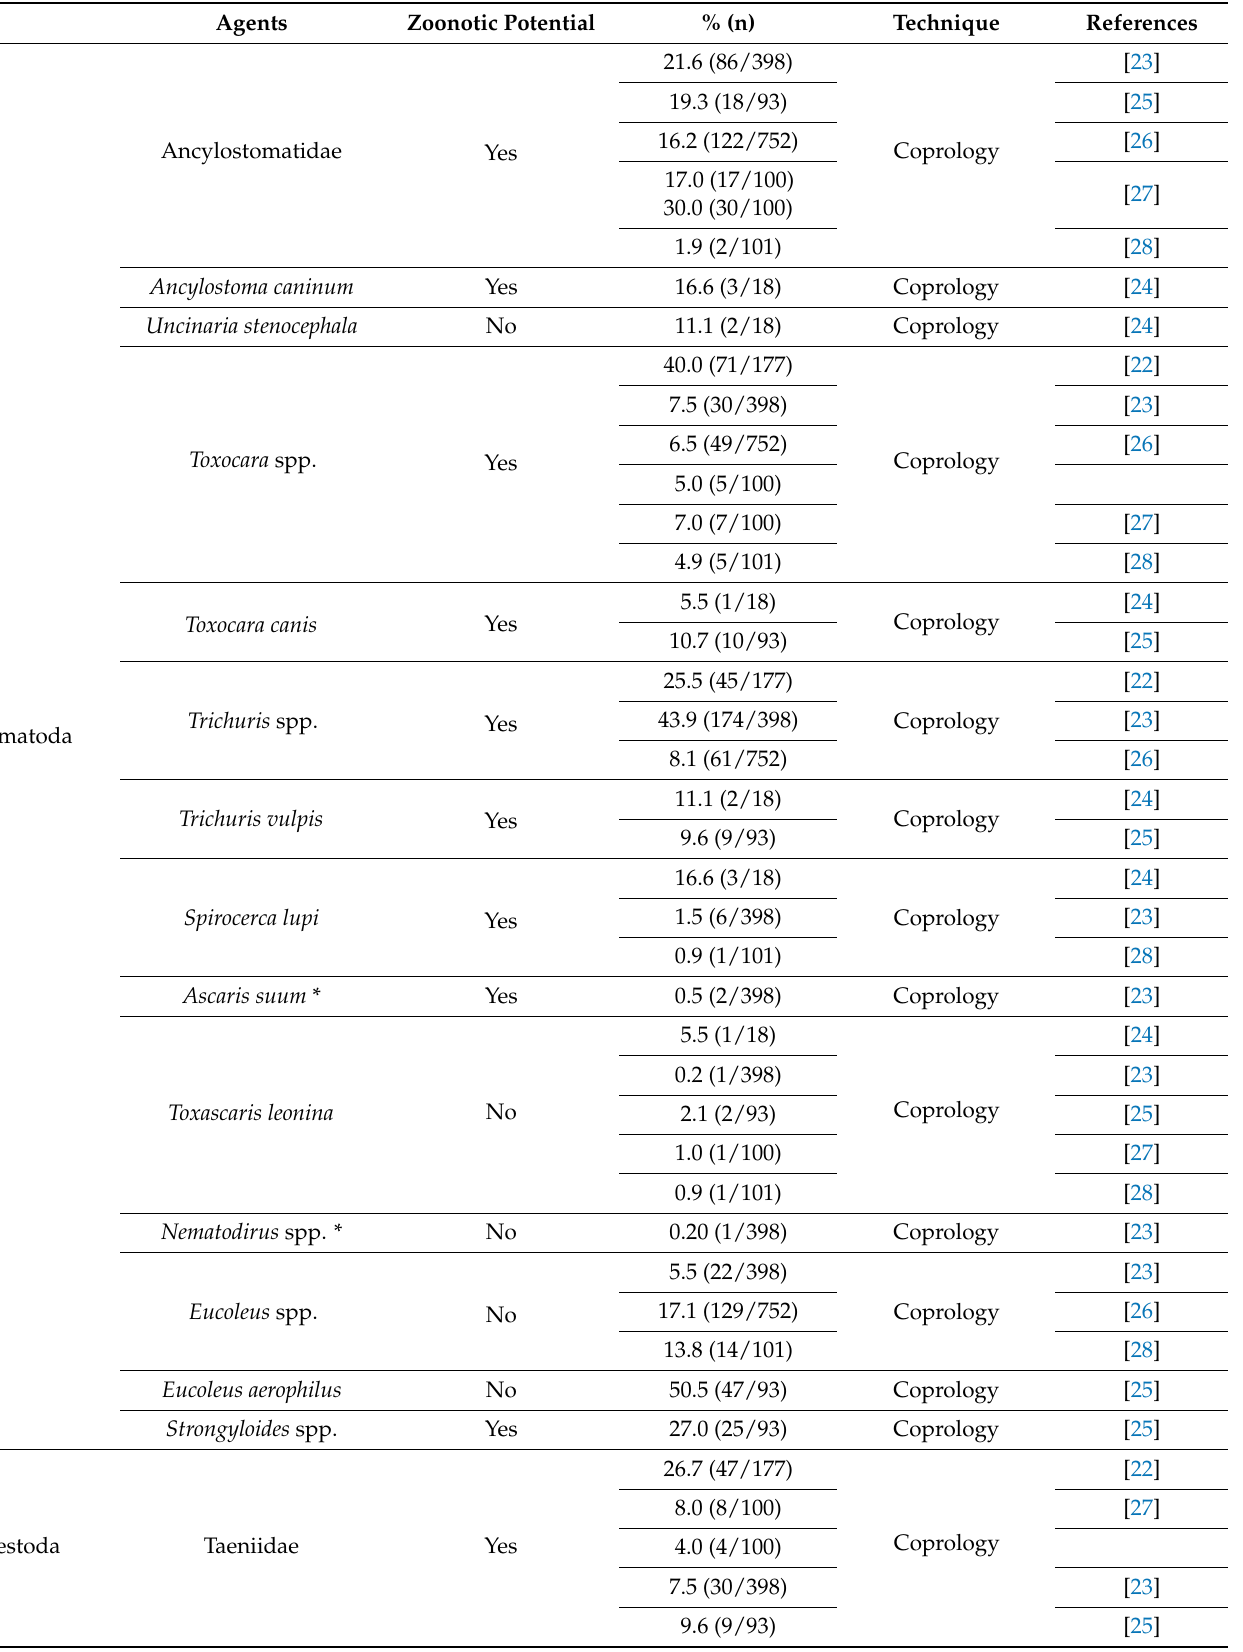
Table 3. Prevalence (%) of parasitic agents reported in wolves in Spain